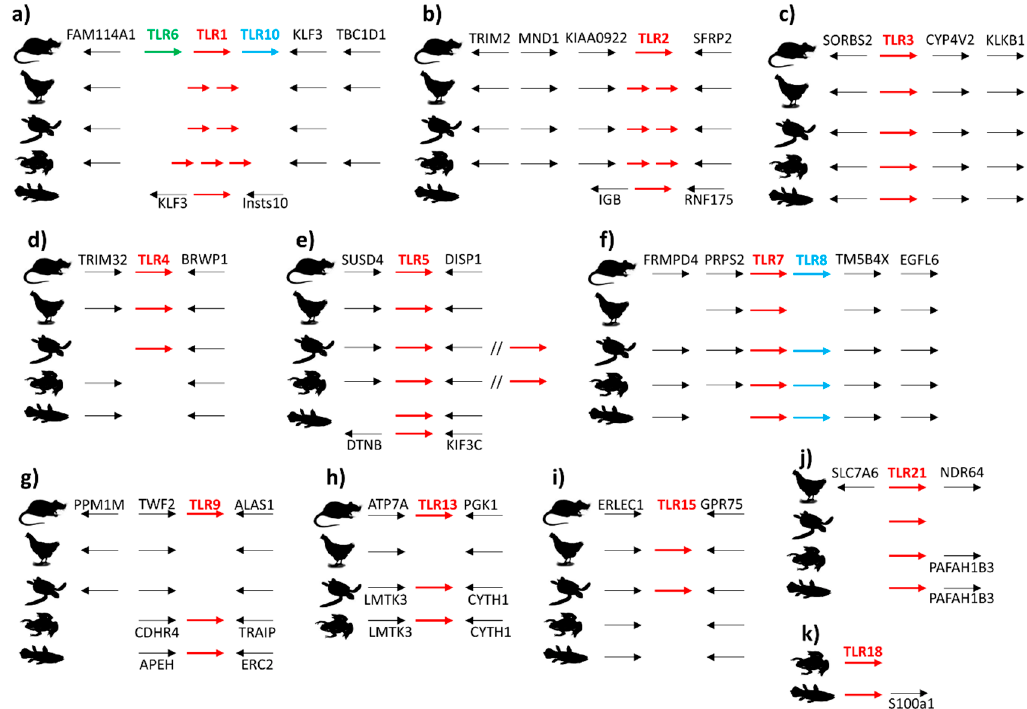
Figure 3. Genomic organization of TLRs clusters present in two or more classes of vertebrates. ( a ) Syntenic organization of TLR6, TLR1, and TLR10 genes whereas only TLR1 is widespread across all vertebrates; ( b ) Syntenic organization of TLR2 genes; ( c ) Syntenic organization of TLR3; ( d ) Syntenic organization of TLR4 only present in mammals, avians, and reptiles; ( e ) Syntenic organization of TLR5; ( f ) Syntenic organization of TLR7 and TLR8; ( g ) Syntenic organization of TLR9 which is absent in avian and reptilian; ( h ) Syntenic organization of TLR13 present in tetrapods (with exception of avian); ( i ) Syntenic organization of TLR15 exclusive of reptiles and avian; ( j ) Syntenic organization of TLR21.